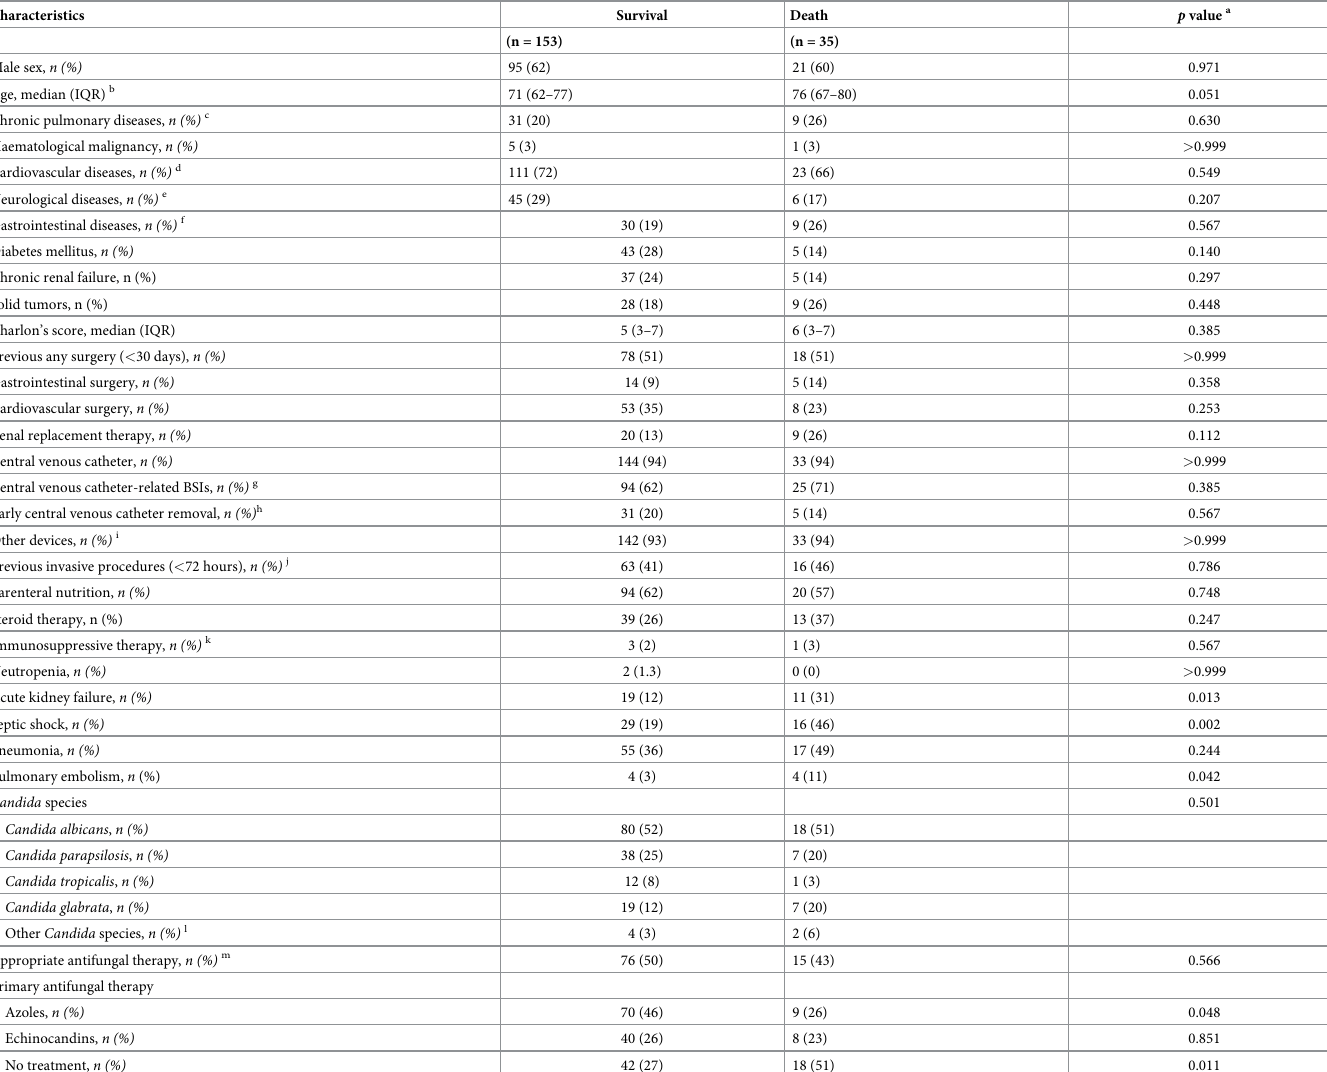
Table 2. Characteristics of ICU patients with candidemia: 7-day mortality.